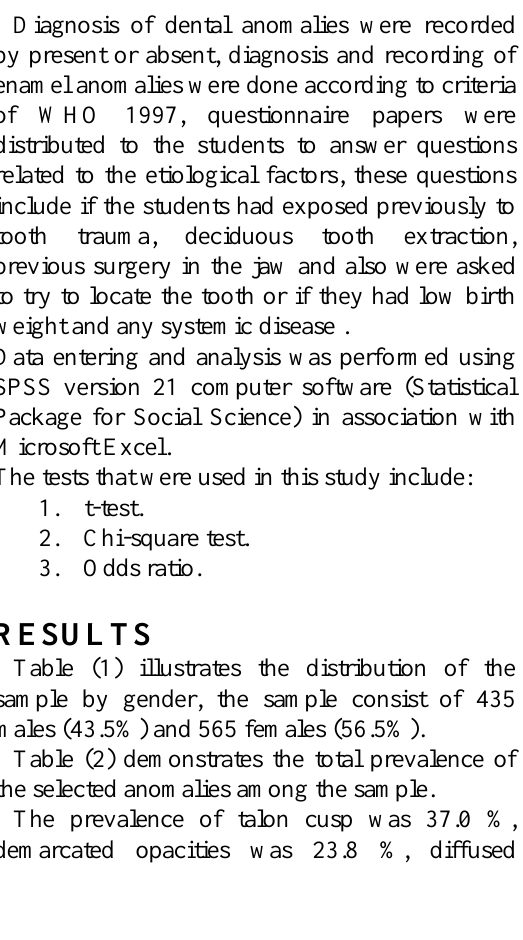
Table 1: The distribution of the sample by gender